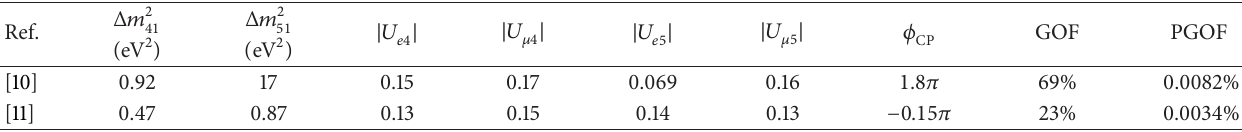
Table 6: The best fit values from 3 + 2 global fits to the world neutrino data from [10, 11]. Also the goodness of fit probability (GOF) and the parameter goodness of fit probability (PGOF) are shown.